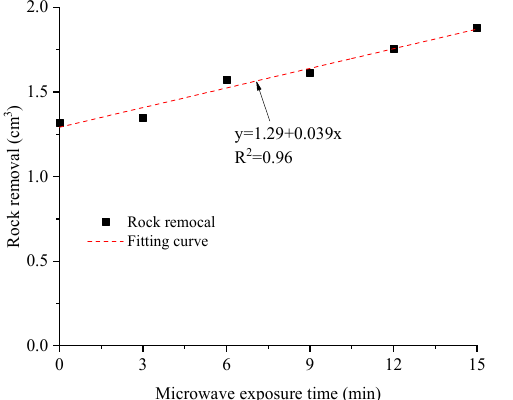
Figure 10. Changes in rock removal using a reduced-scale TBM cutter with the microwave exposure time.